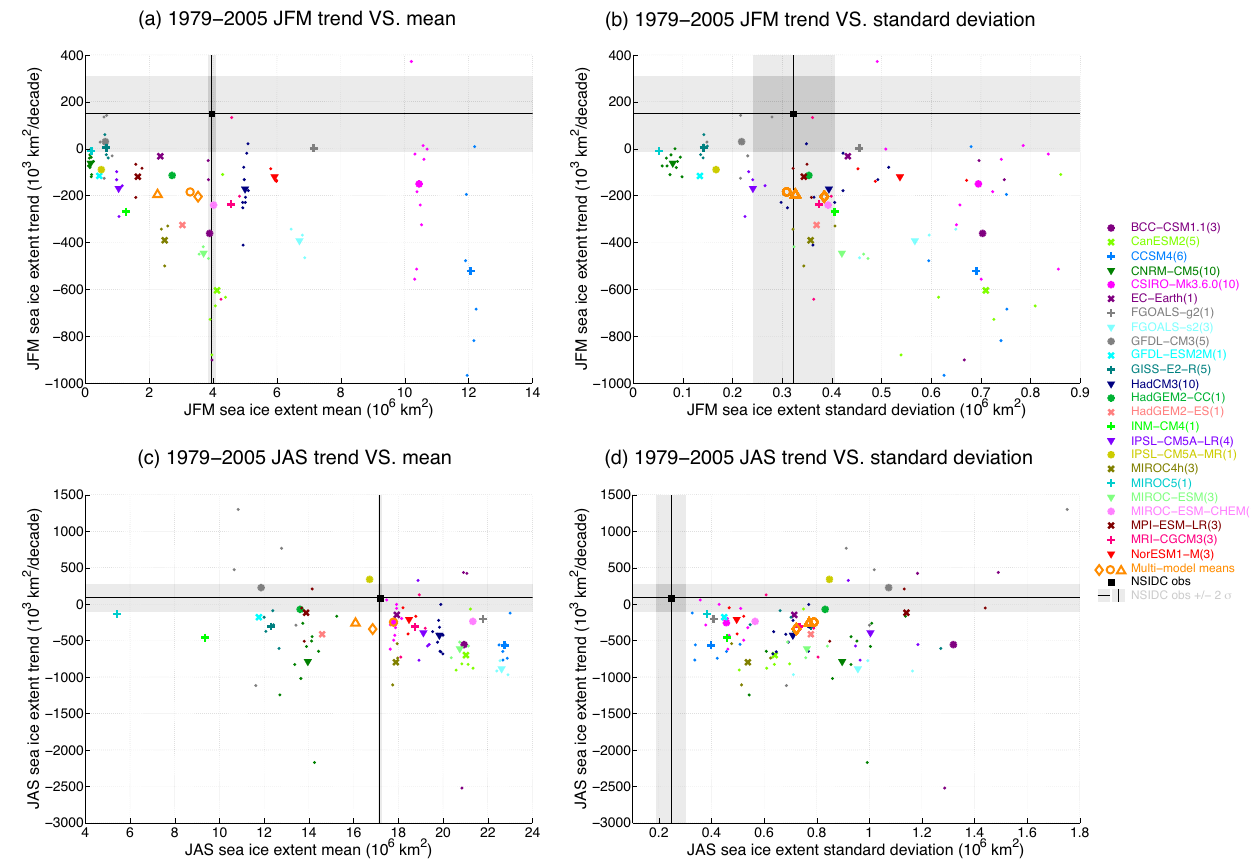
Fig. 3. Sea ice extent trend for the period 1979–2005 over the whole Southern Ocean vs. mean (a, c) and standard deviation (b, d) . The first row corresponds to summer (JFM), the second to winter (JAS). The different colours correspond to the historical simulations from 24 different models. For each colour, the small dots refer to model individual members and the symbol specified in the legend is for the model ensemble mean. The number of members in each model is indicated in brackets in the legend. Orange refers to multi-model means, for which the diamond sign is for the average over all the models, circle sign is for the mean of models with interactive chemistry (in bold in Table 2) and triangle sign is for the mean of models with 35 atmospheric levels or more on the vertical. Black square is for the observations (Cavalieri and Parkinson, 2008), surrounded by 2 standard deviations (dark-grey rectangle). Horizontal (vertical) solid black line with the light-grey shade refers to the trend (mean/standard deviation) of the observations along with 2 standard deviations. The computed standard deviation of the observed trend takes into account the autocorrelation of the residuals (see for instance Santer et al., 2000; Stroeve et al., 2012).